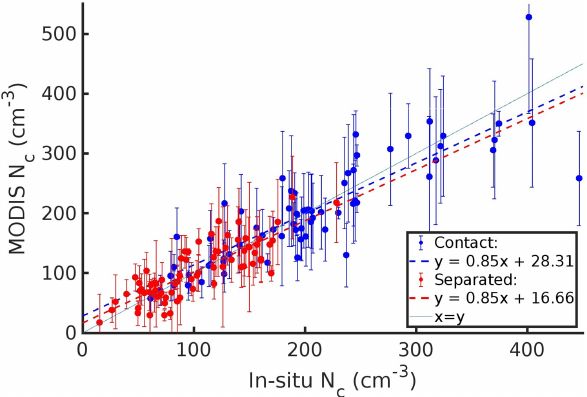
Figure 16. Same as Fig. 11 but with cloud profiles colored based on regime